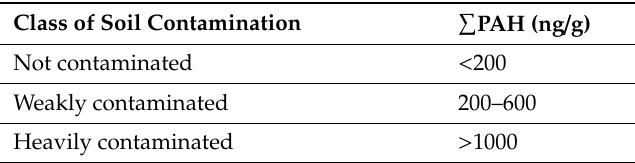
Table 6. Classification of soil contamination by PAHs